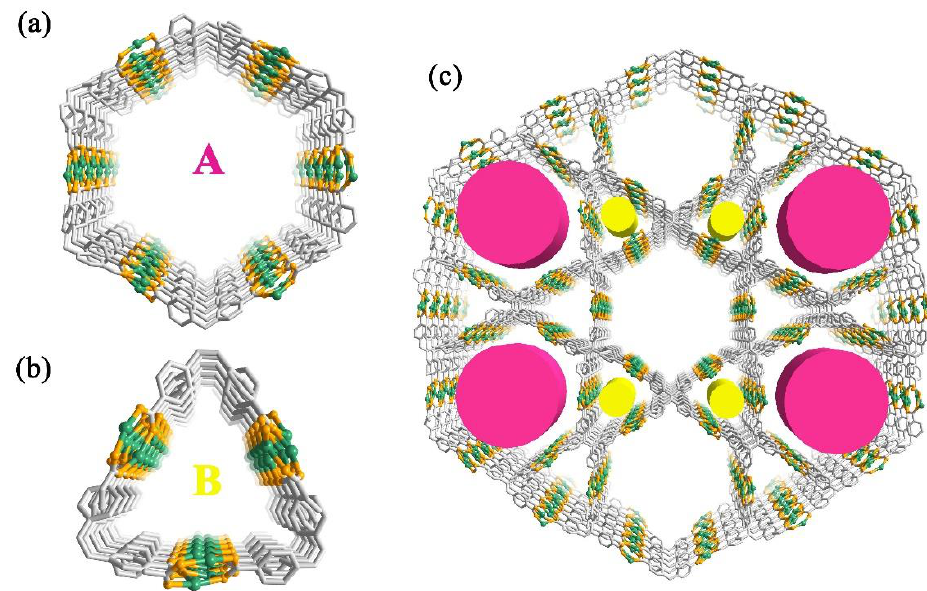
Figure 2. The triangular channel ( a ) and a hexagonal channel ( b ) in 1 ; ( c ) Structure of 1 showing the three-dimensional network with one-dimensional channels.